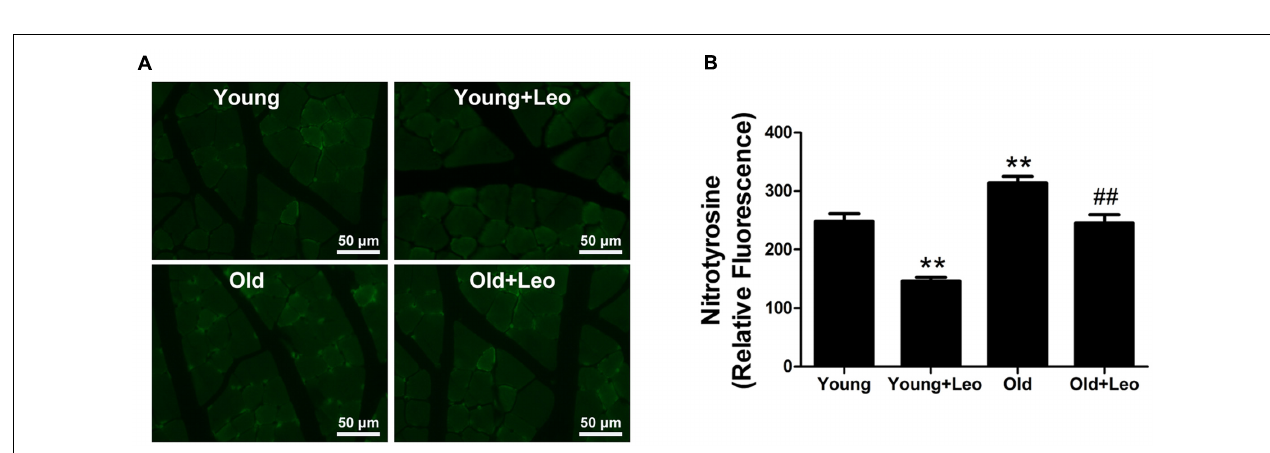
FIGURE 4 | Effects of aging and leonurine on capillary density and expressions of HIF and VEGF. (A) CD31 immunostaining of ischemic skeletal muscles harvested at post-surgical day 14 in each group. Scale bar = 50 µ m. (B) Quantification of capillary density. (C,D) Effects of aging and leonurine on the expressions of HIF and VEGF in ischemic skeletal muscles assessed by Western blot. Data are mean ± SEM. ∗∗ p < 0.01 vs. young group; ## p < 0.01 vs. old group. n = 5–8 for each group.